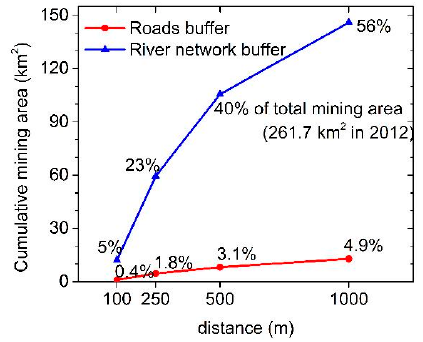
Figure 12. Cumulative mining and deforestation areas for 2012 along river and road buffer zones for 100, 250, 500, and 1000 m.